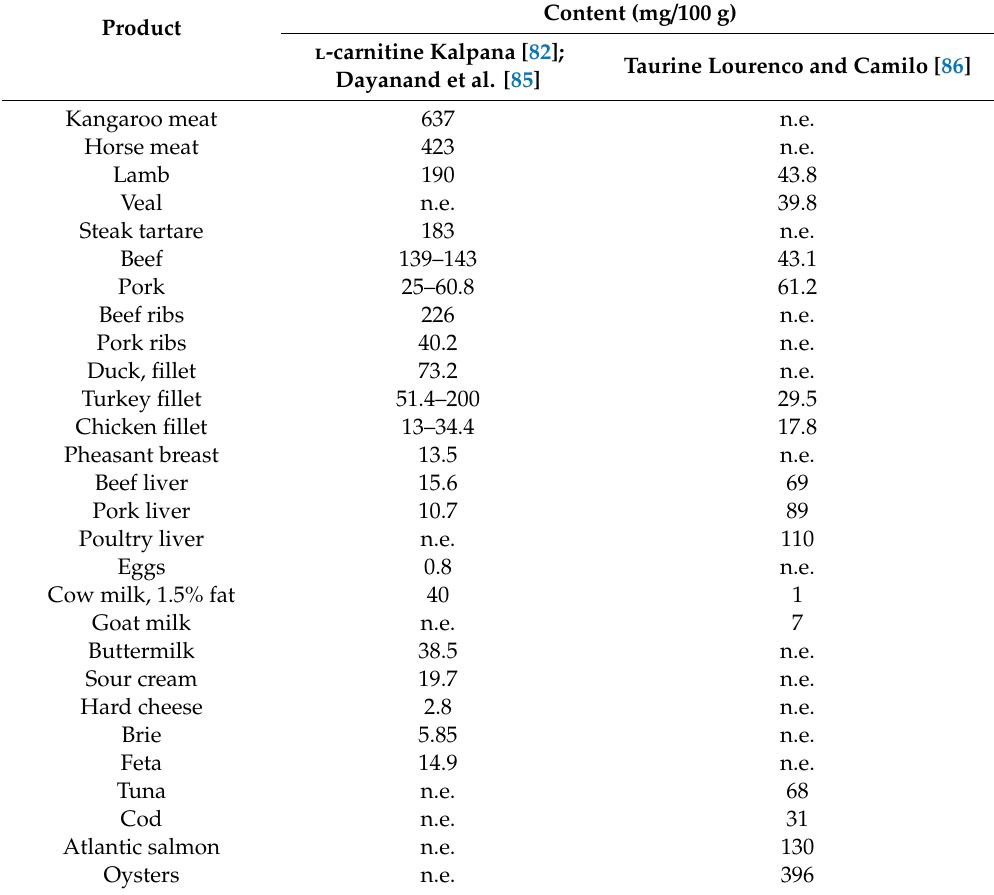
Table 3. Contents of l -carnitine and taurine in meat and animal origin